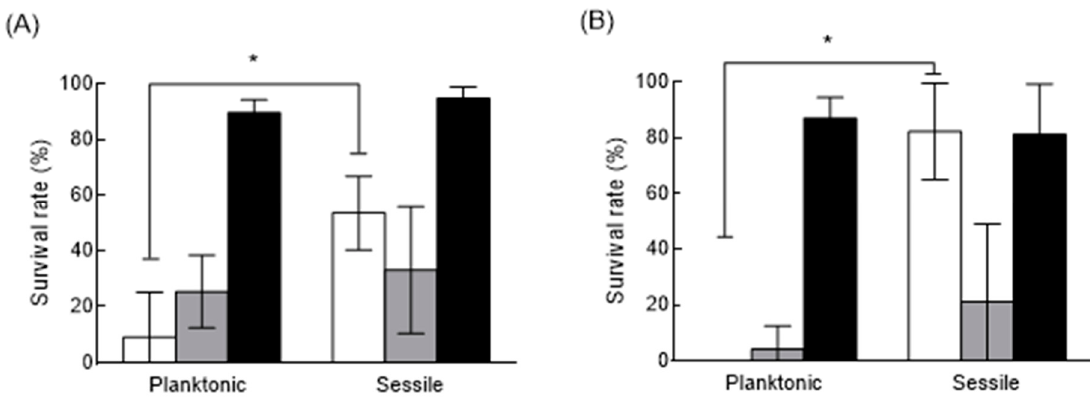
Figure 4. Survival of C. perfringens vegetative cells and spores among planktonic and sessile cells after exposure to disinfectants. Survival rate of TYJAM-D-66 vegetative cells ( A ) and spores ( B ) grown after exposure to 0.001% sodium hypochlorite ( □ ), 5% hydrogen peroxide ( ▪ ), and 80% ethyl alcohol ( ▪ ) for 10 min. The asterisk represents statistical significance ( p < 0.05) among experimental groups.